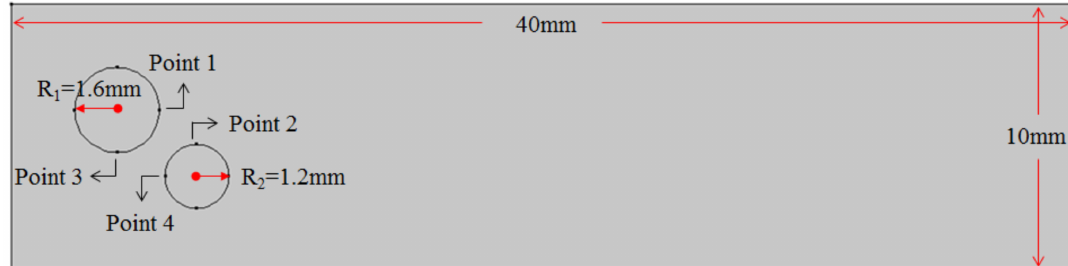
Figure 2. Geometry